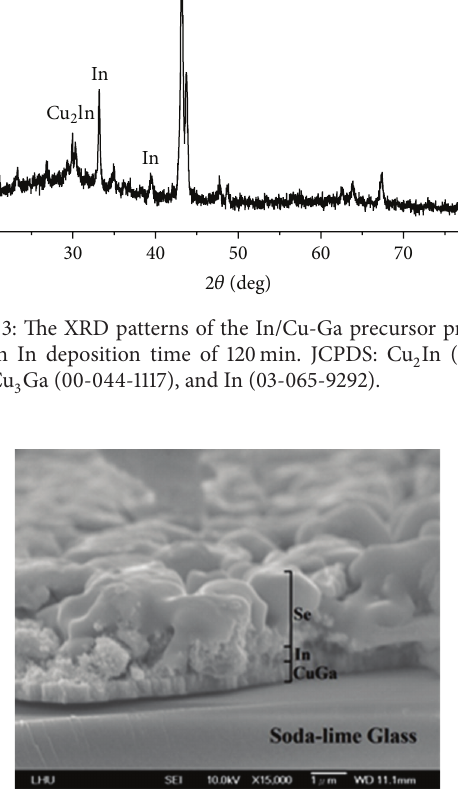
Figure 4: Cross-sectional SEM image of the solid Se-coated In/Cu- Ga precursor.